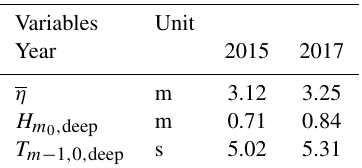
Table 3. Measured waves and water levels at the marsh edge during the 2015 and 2017 winter storms at